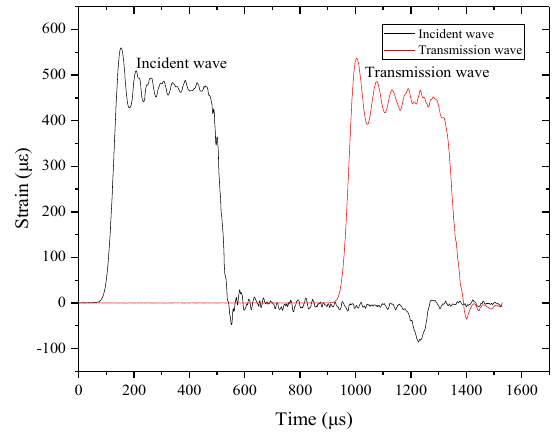
Figure 2. Typical shaped waveforms during SHPB tests (no specimen).